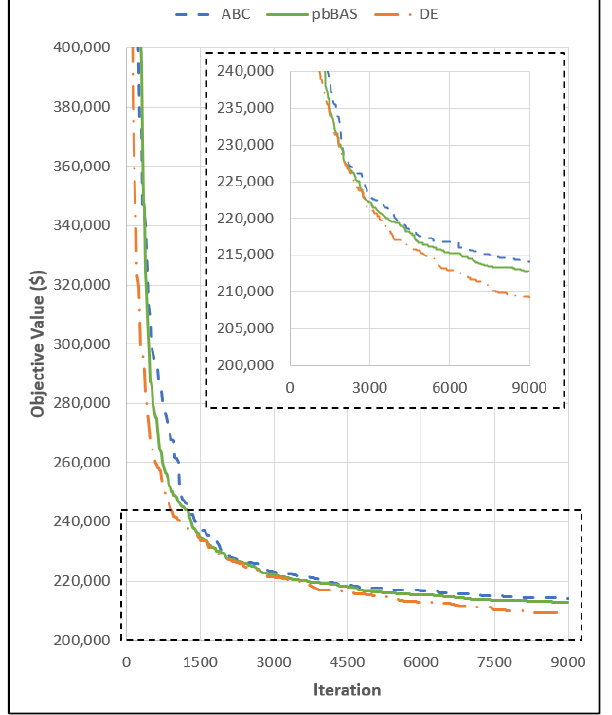
Figure 19. Design history of the sample average of the 10 runs achieved by each metaheuristic algorithm for the three-segment type folded plate roof problem.